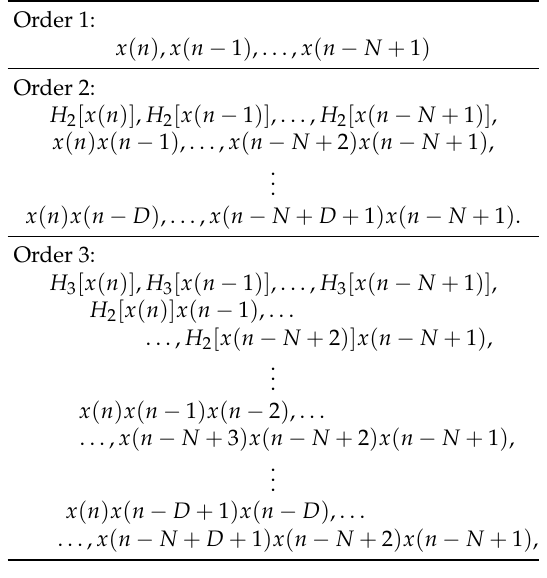
Table 2. Basis functions of Wiener nonlinear (WN)